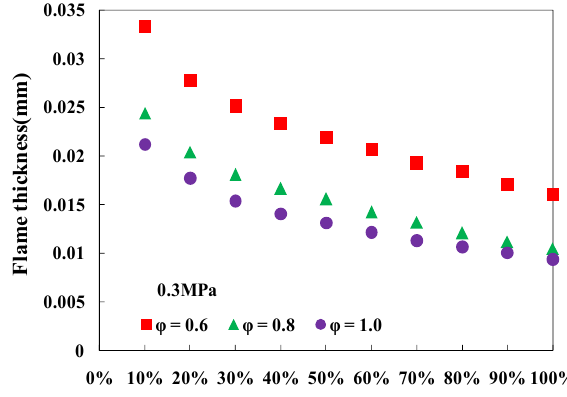
Figure 9. Flame thickness plotted against hydrogen